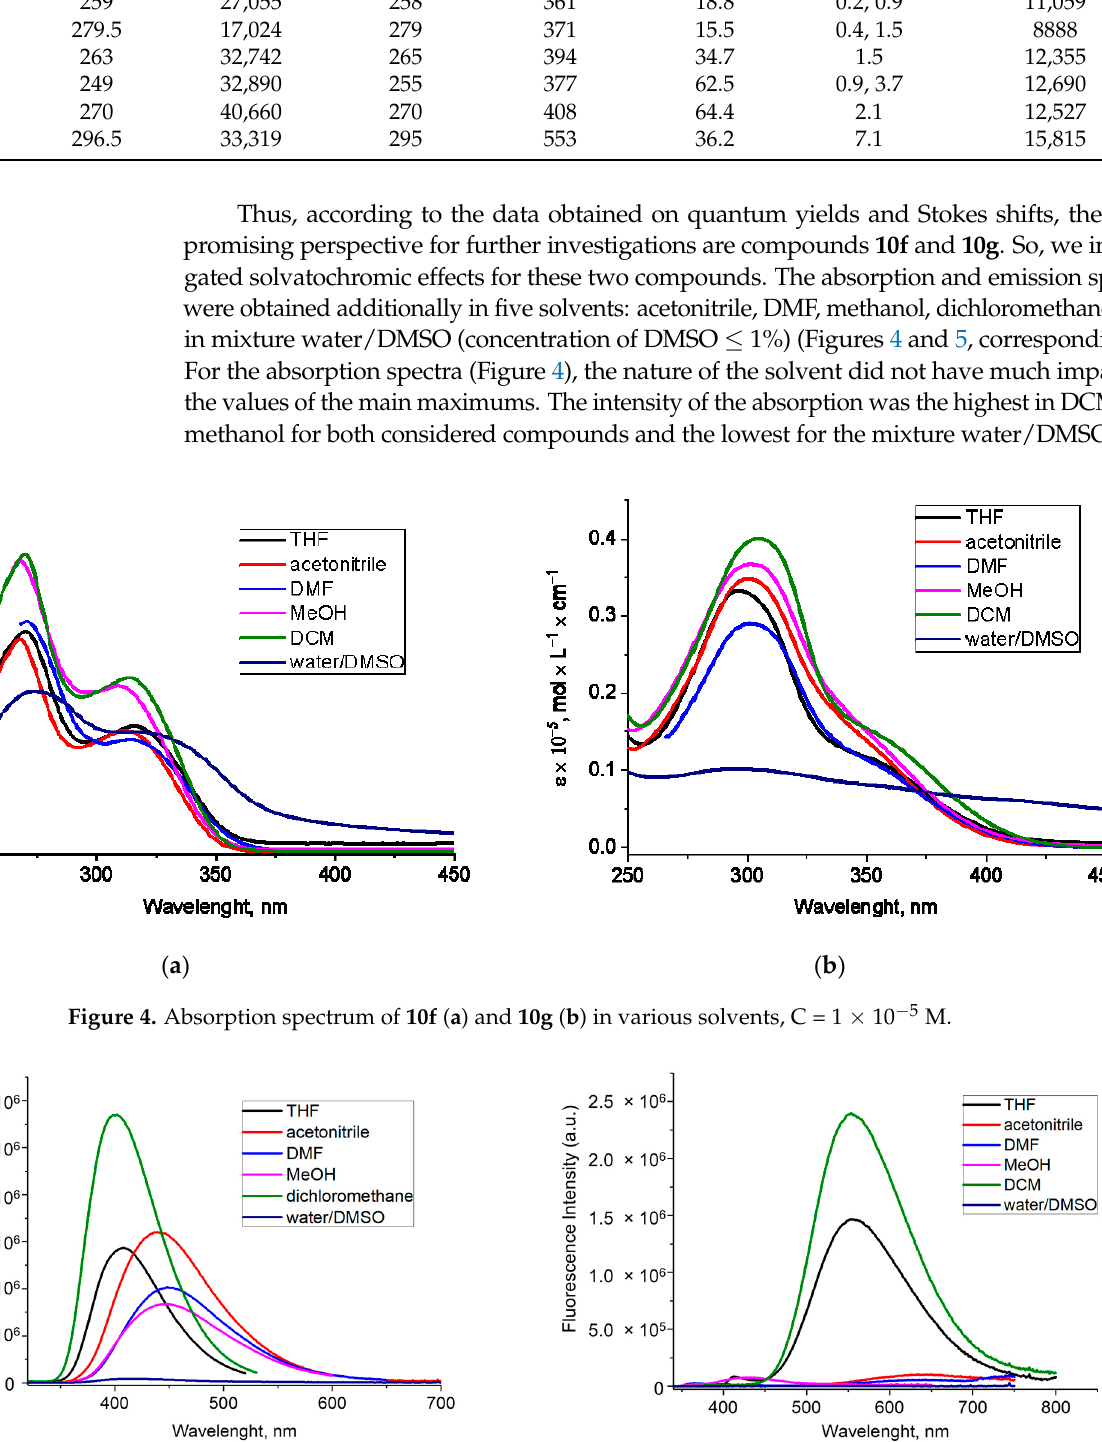
Table 1. Photophysical parameters of 10a – g (THF solutions).